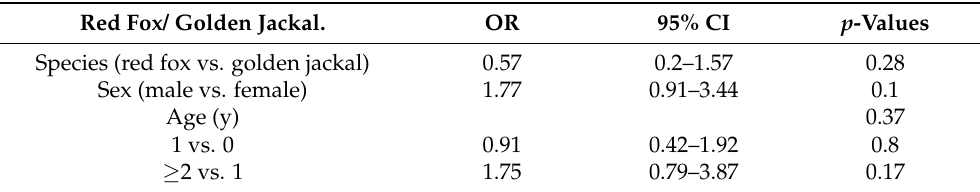
Table 3. Risk factors for prevalence of E. multilocularis in red fox and golden jackal. Results are conditional odds ratio (OR), 95% confidence intervals (CI), and p -values (model area under the curve 0.77). Red Fox/ Golden Jackal. OR 95% CI p -Values Species (red fox vs. golden jackal) 0.57 0.2–1.57 0.28 Sex (male vs. female) 1.77 0.91–3.44 0.1 Age (y) 0.37 1 vs. 0 0.91 0.42–1.92 0.8 ≥ 2 vs. 1 1.75 0.79–3.87